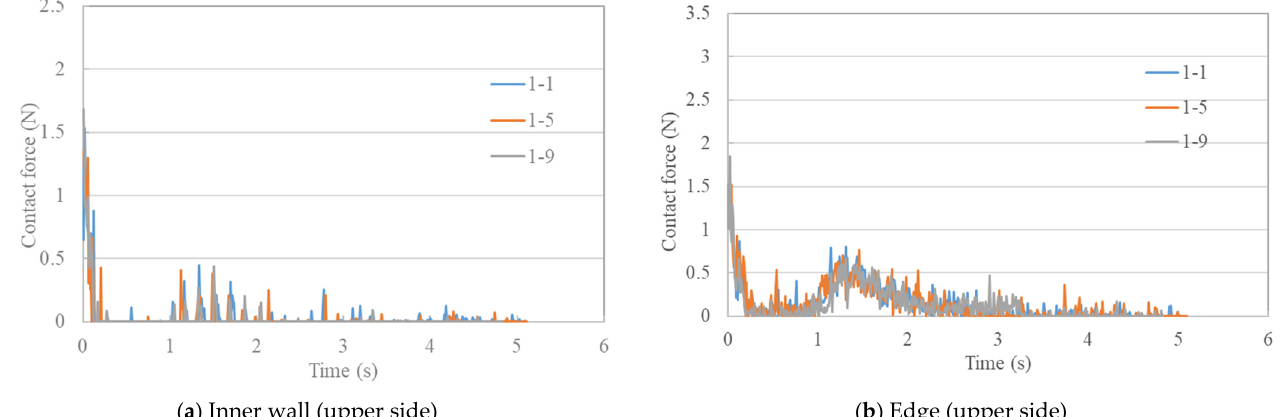
Figure 18. ( a , b ) Time history of contact force between inside of inlet and elastic wall at inlet tip after application of second tension.